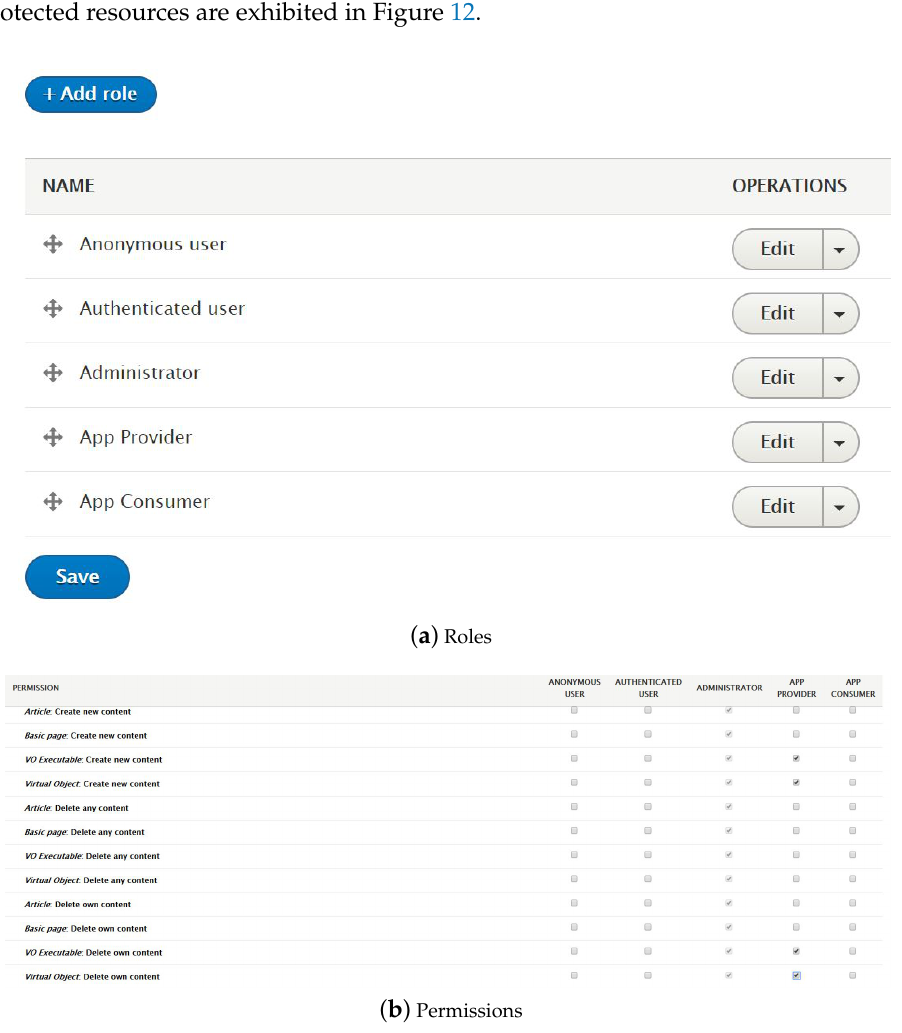
Figure 12. Role and permission